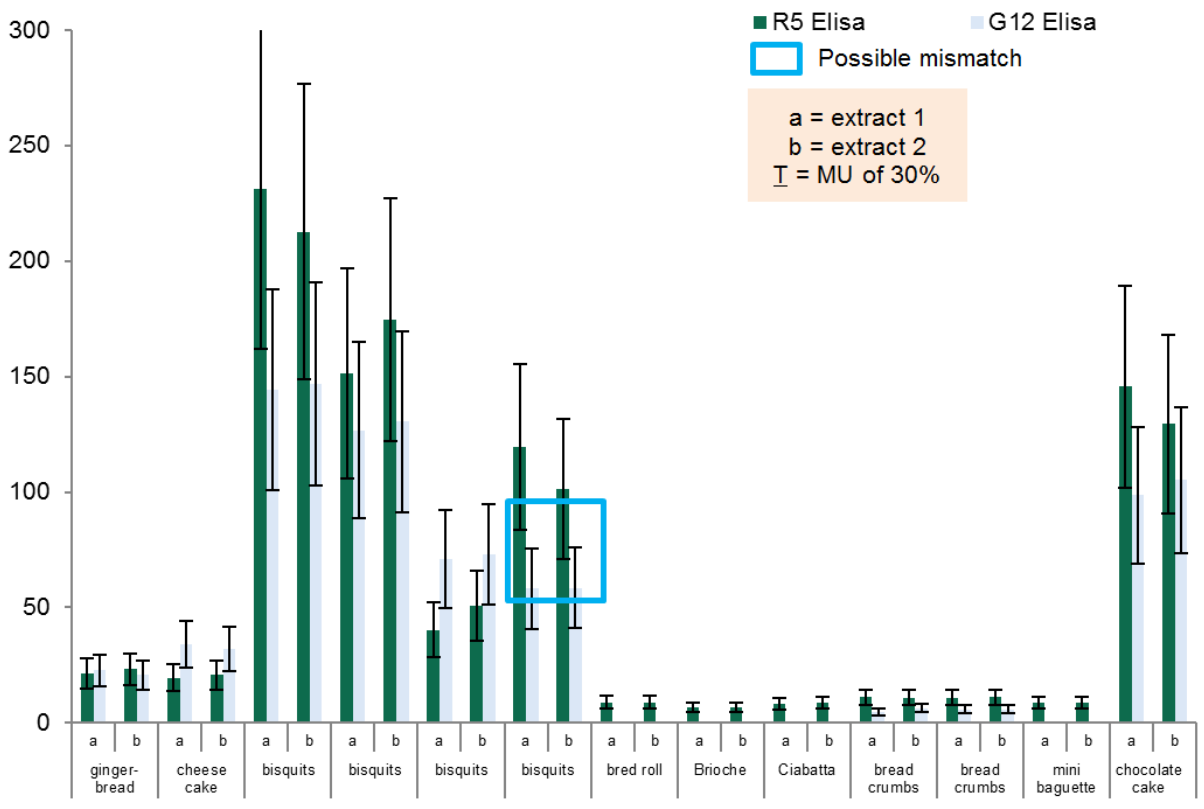
Figure 2. Results for the group of bakery